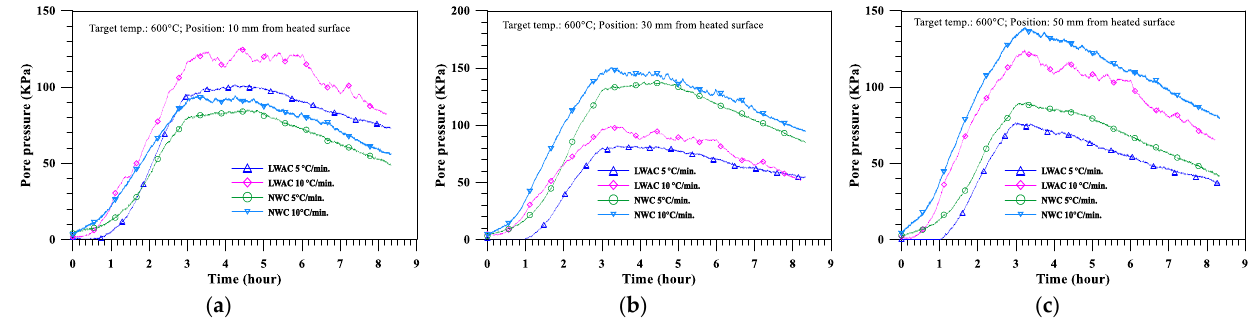
Figure 20. Effect of heating rate on the pore pressure of oven-dried specimens performed at a target temperature of 600 °C: ( a ) 10; ( b ) 30; ( c ) 50 mm depths.